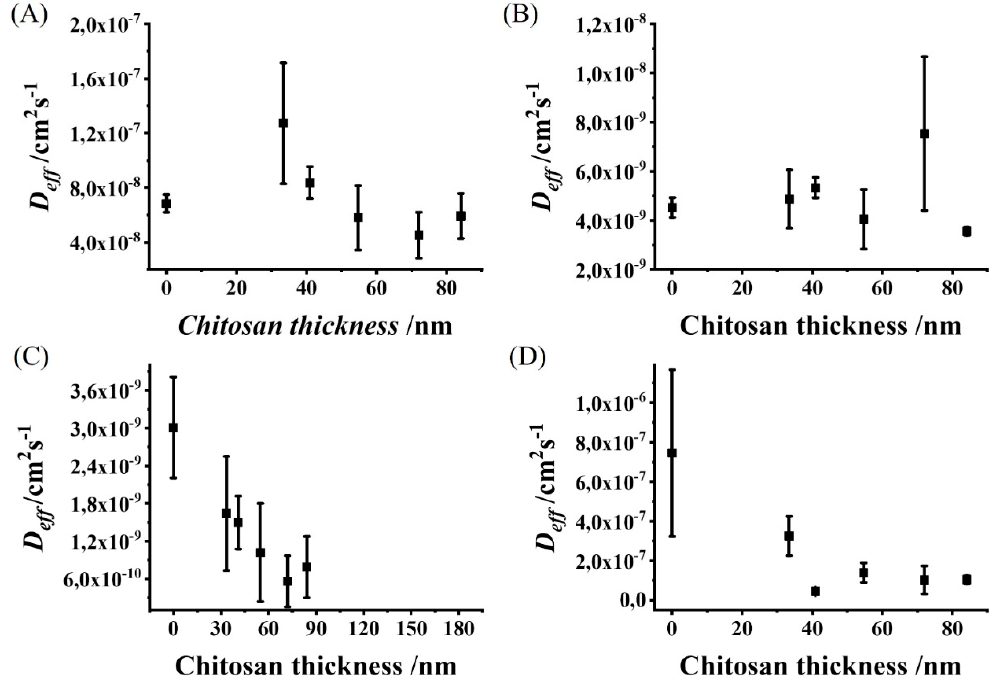
Figure 5. The influence of the chitosan thickness on the diffusion rate for differentially charged redox-active molecules. D eff dependence on the chitosan film thickness for ( A ) Ferri, ( B ) AA, ( C ) HCy, and ( D ) CLZ redox-active molecules.